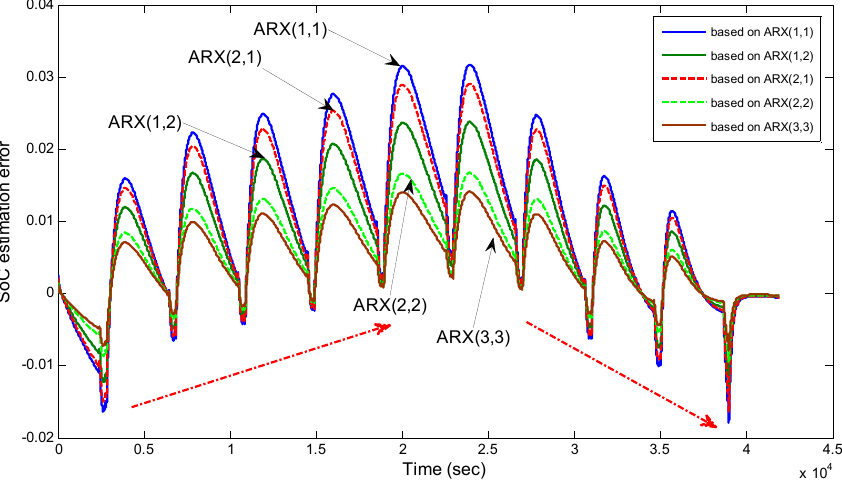
Figure 19. SOC estimation errors based on HPPC cycles